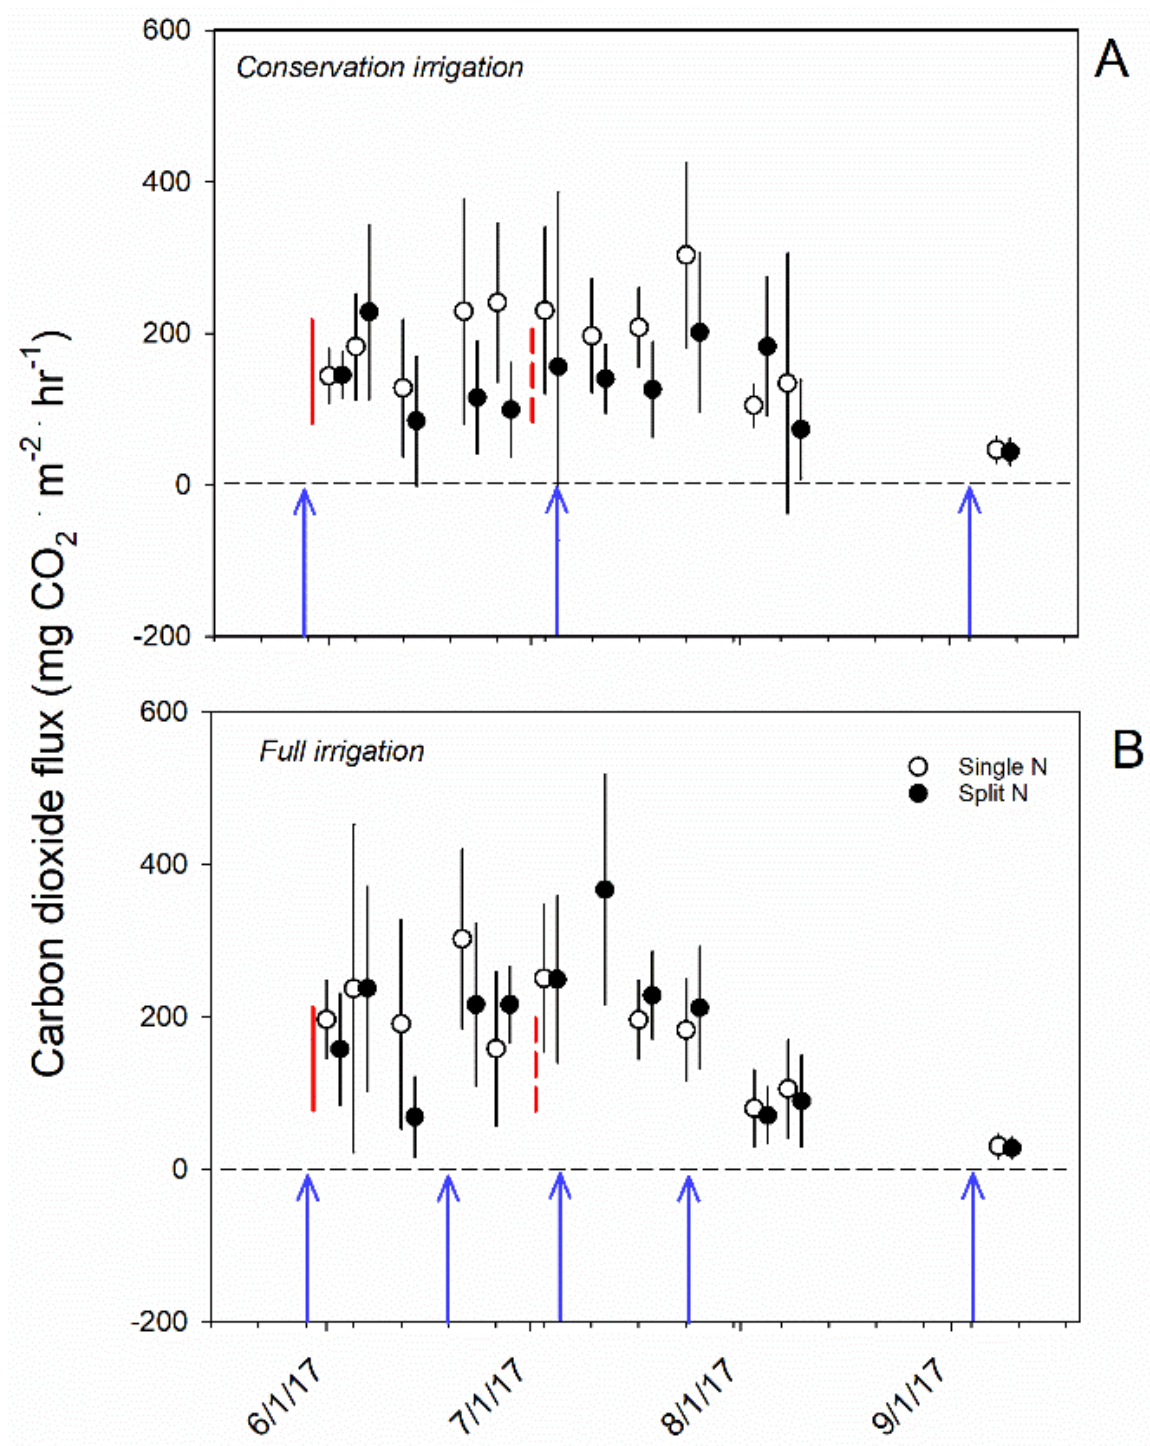
Figure 8. Soil respiration (CO 2 flux) from a sorghum field under ( A ) 30% less irrigation and ( B ) full irrigation, and with N fertilizer applied once at the start of the growing season or split between two applications. Red vertical lines denote when fertilizer was applied (second application timing for split = dashed line). Blue arrows denote irrigation events. Values are mg CO 2 · m − 2 · hr − 1 , mean flux per treatment per sample date ± 1 SD.